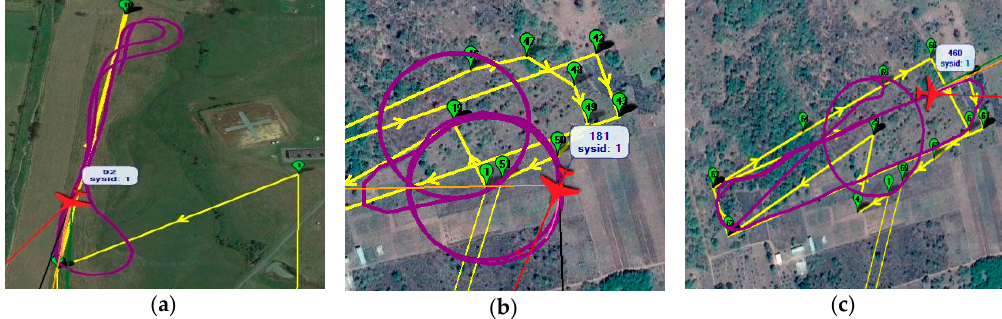
Figure 9. Flight patterns: ( a ) Flight conducted in Lannemezan site. The 60 m tower is situated around 200 m to the south of the lower left corner of the picture (length of straight flight: around 500 m); ( b ) flight conducted in DACCIWA site on June 29, 2016 (Radius circle: 100 m); and ( c ) flight conducted in DACCIWA site on July 15, 2016 (radius circle: 100 m; and length of straight flight: 700 m). Afterwards, the drone participated in the DACCIWA campaign in West Africa (Sav è ,